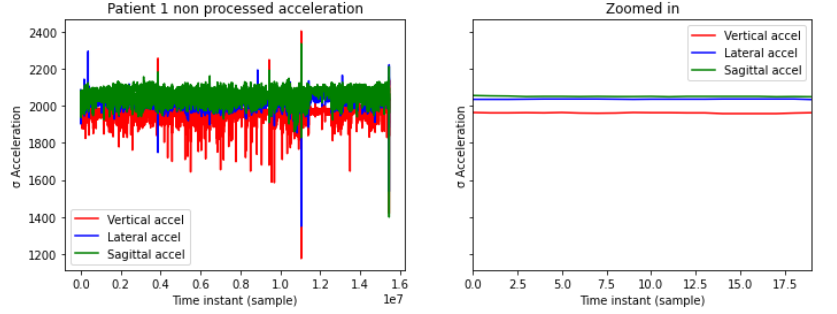
Figure 2. Patient 1 acceleration levels.